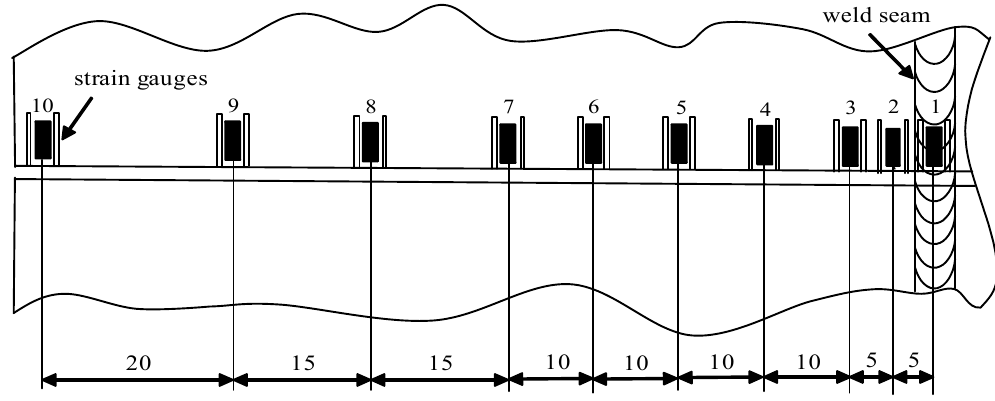
Figure 13. Strain gauge location arrangement for stress measurement.